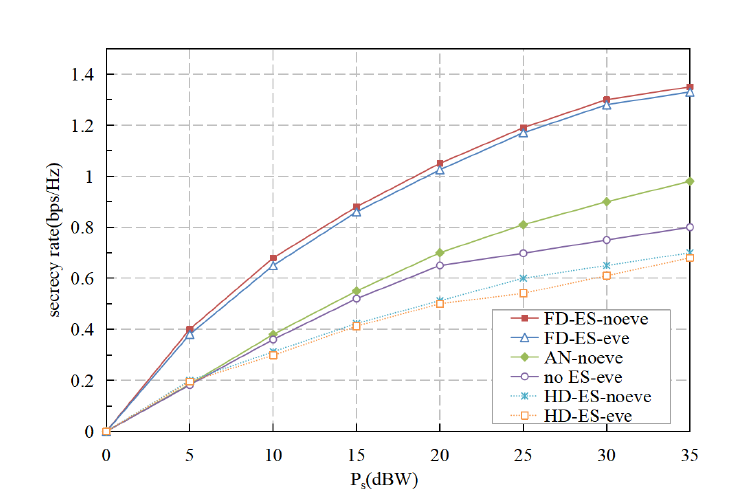
Figure 3. Secrecy rate vs. source transmission